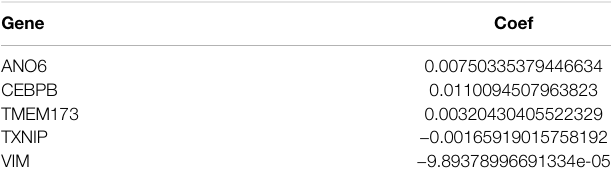
TABLE 1 | The names and the coef fi cients of the prognostic